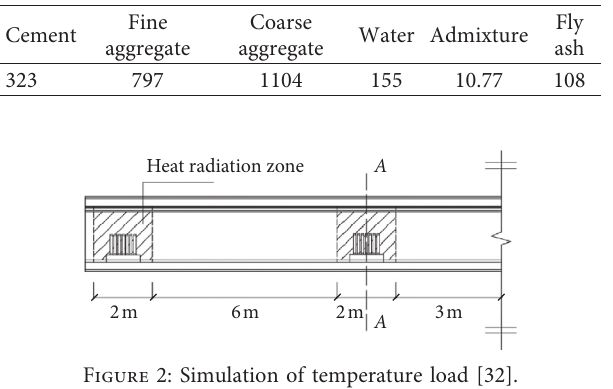
Figure 2: Simulation of temperature load [32].